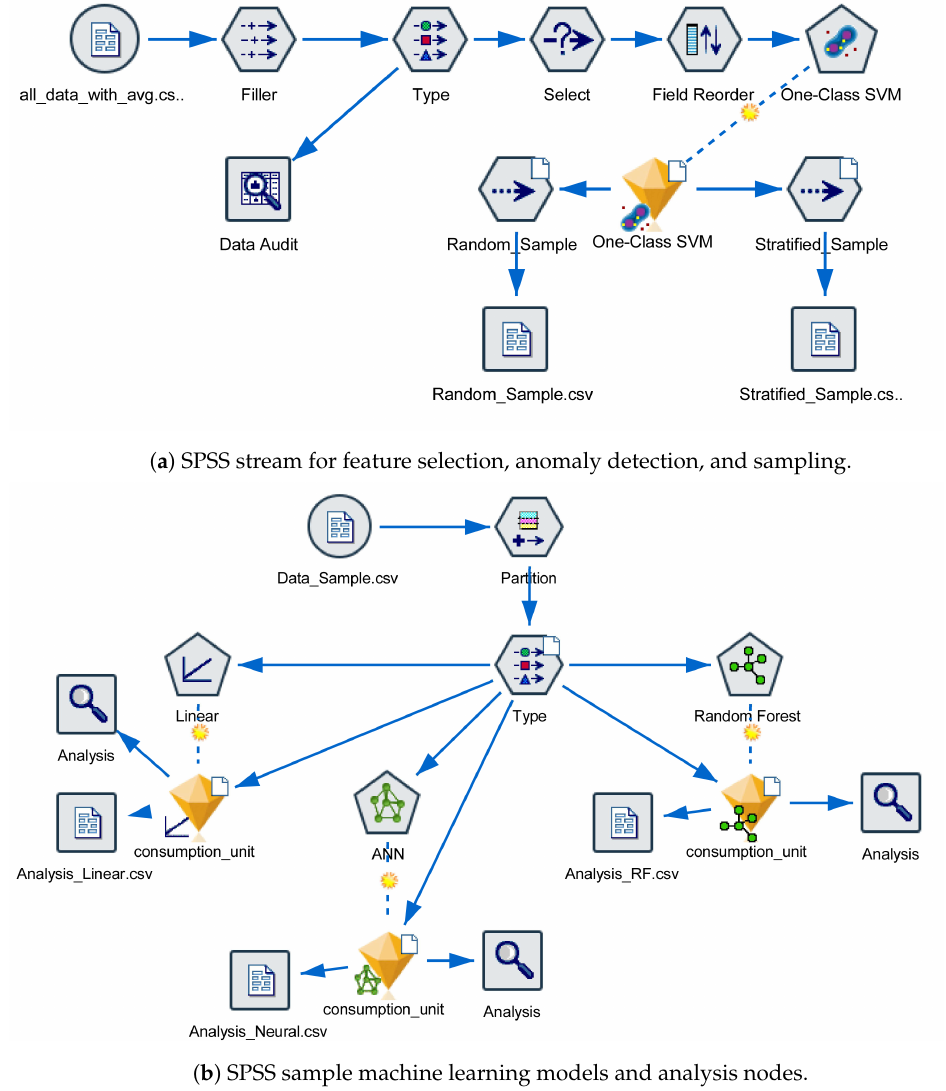
Figure 8. Stream components of the machine learning models in the SPSS